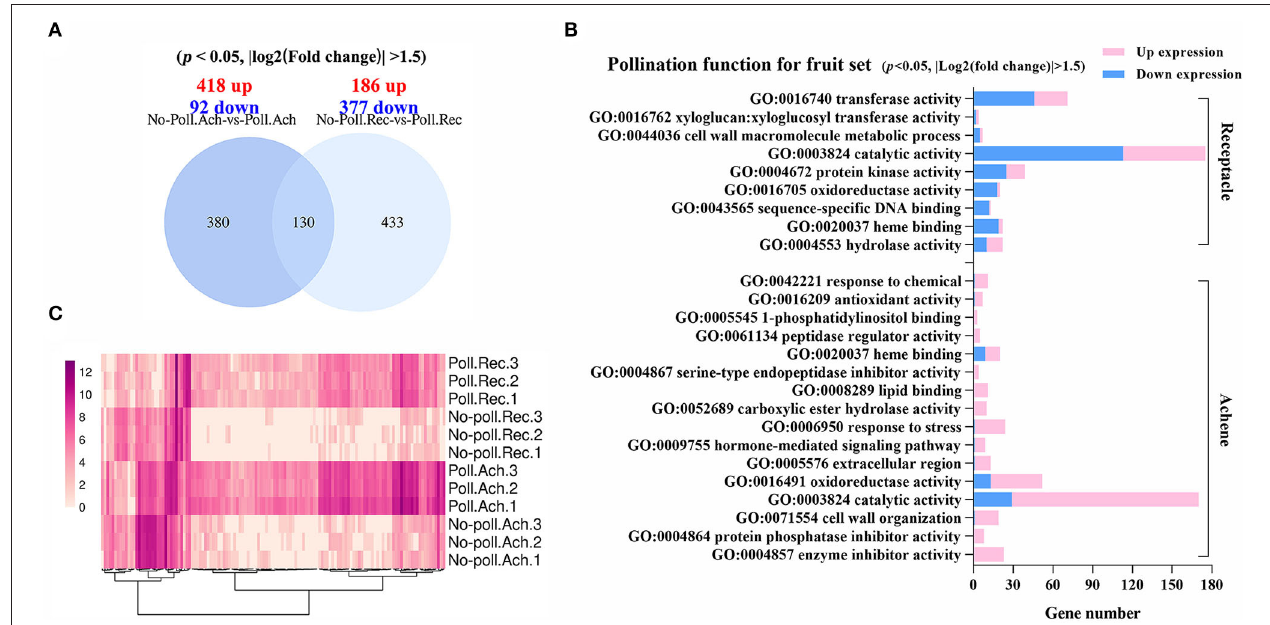
FIGURE 4 | Gene regulation in response to pollination. (A) Venn shows the relationship for the DEGs identified in the pollinated achenes and receptacles ( p < 0.05, |log2(fold change)| > 1.5). (B) Significantly enriched GO terms of the DEGs in achenes and receptacles, respectively. P < 0.05. (C) Heatmap analysis of the overlapping 130 DEGs. Expression values were converted into log2(value + 10 − 6